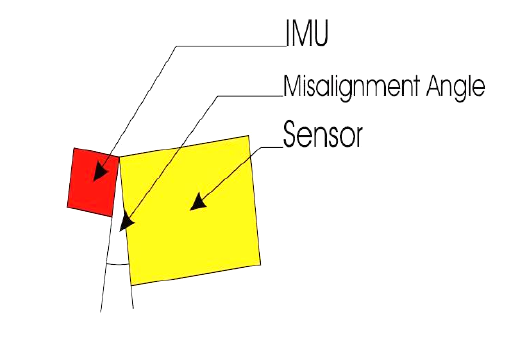
Figure 1: Misalignment